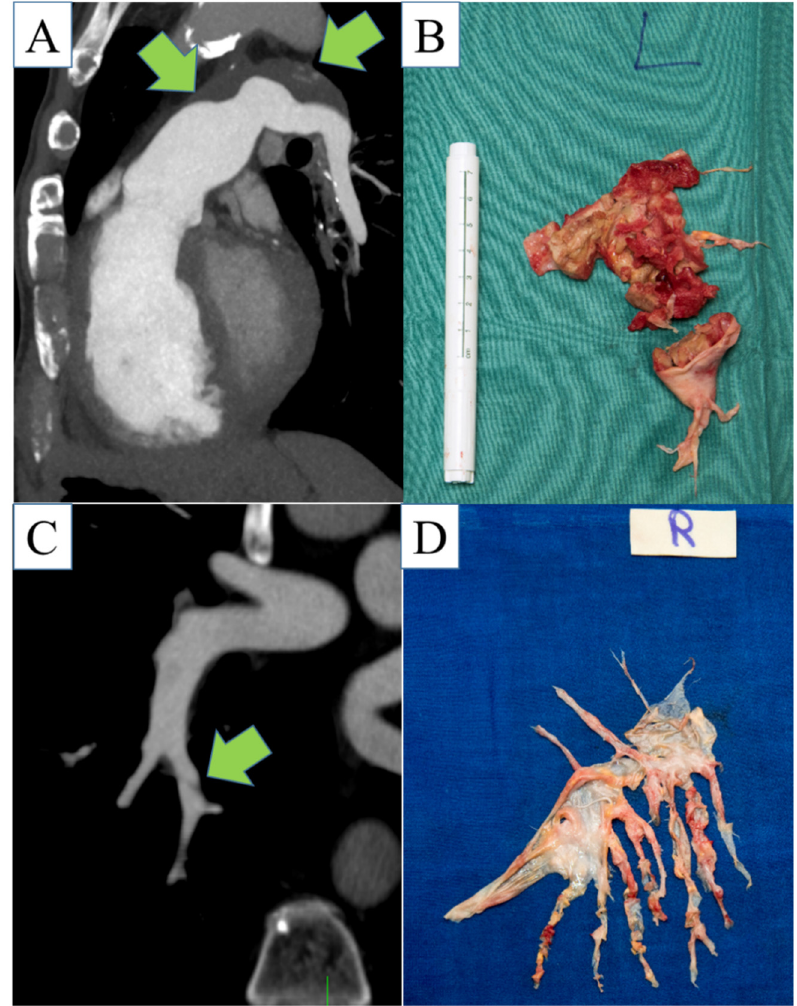
Figure 2. Exemplary cases: Panel ( A ) (multiplanar CT reconstruction) and ( B ) (surgical specimen) show a case of extensive chronic thromboembolic changes in a 64-year-old male patient involving the left pulmonary artery. Panel ( C ) (multiplanar CT reconstruction) and ( D ) (surgical specimen) show distal involvement chronic thromboembolic changes in a 54-year-old male patient involving the segmental pulmonary arteries of the right lower lobe. Table 2. Comparison of radiological versus surgical classification of the level of disease in patients with chronic thromboembolic pulmonary hypertension.